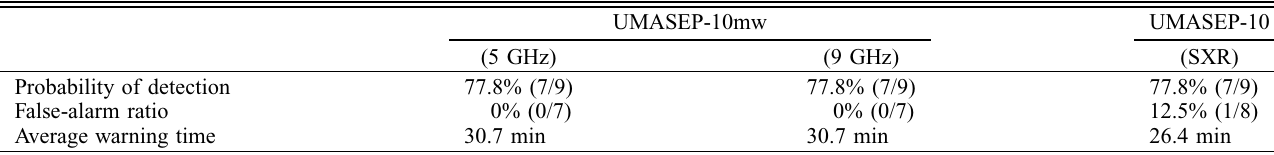
Table 2. Forecast performance results in terms of POD, FAR and average warning time of the UMASEP scheme (WCP model only) using microwave and soft X-ray (SXR) data from 2011 December 01 to 2012 December 31.